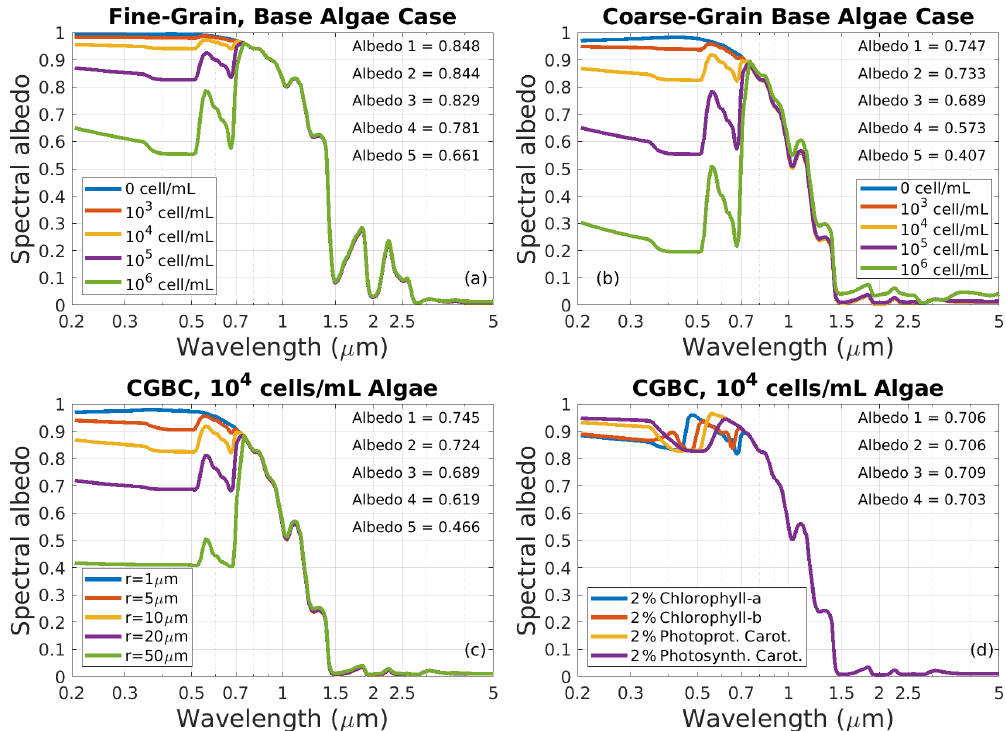
Figure 8. Albedo variations caused by snow algae in SNICAR-ADv3 with default pigment fractions (Table 3) in the fine-grain base case (a) and coarse-grain base case (b) . Dependencies on algal cell radius (c) and individual pigment types (d) are also shown for the coarse-grain base case (CGBC) with a cell number concentration of 10 4 mL − 1 . The order of broadband albedos shown in each panel corre- sponds with the legend